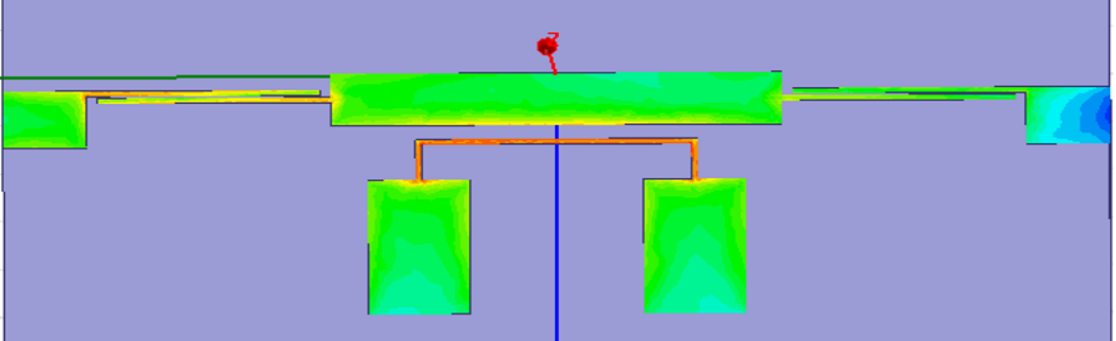
Figure 17. Current distribution of the UWB filter at central frequency 7.2 GHz.